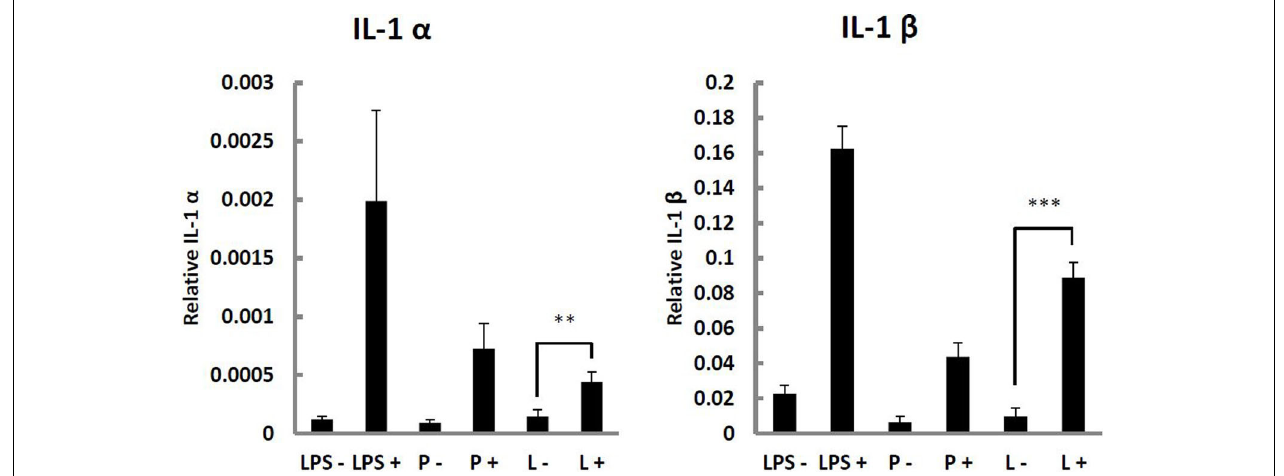
FIGURE 5 | IL-1 α and IL-1 β response of P-388D1 murine macrophages non-activated ( − ), or activated using 100ng/ml IFN- γ ( + ),